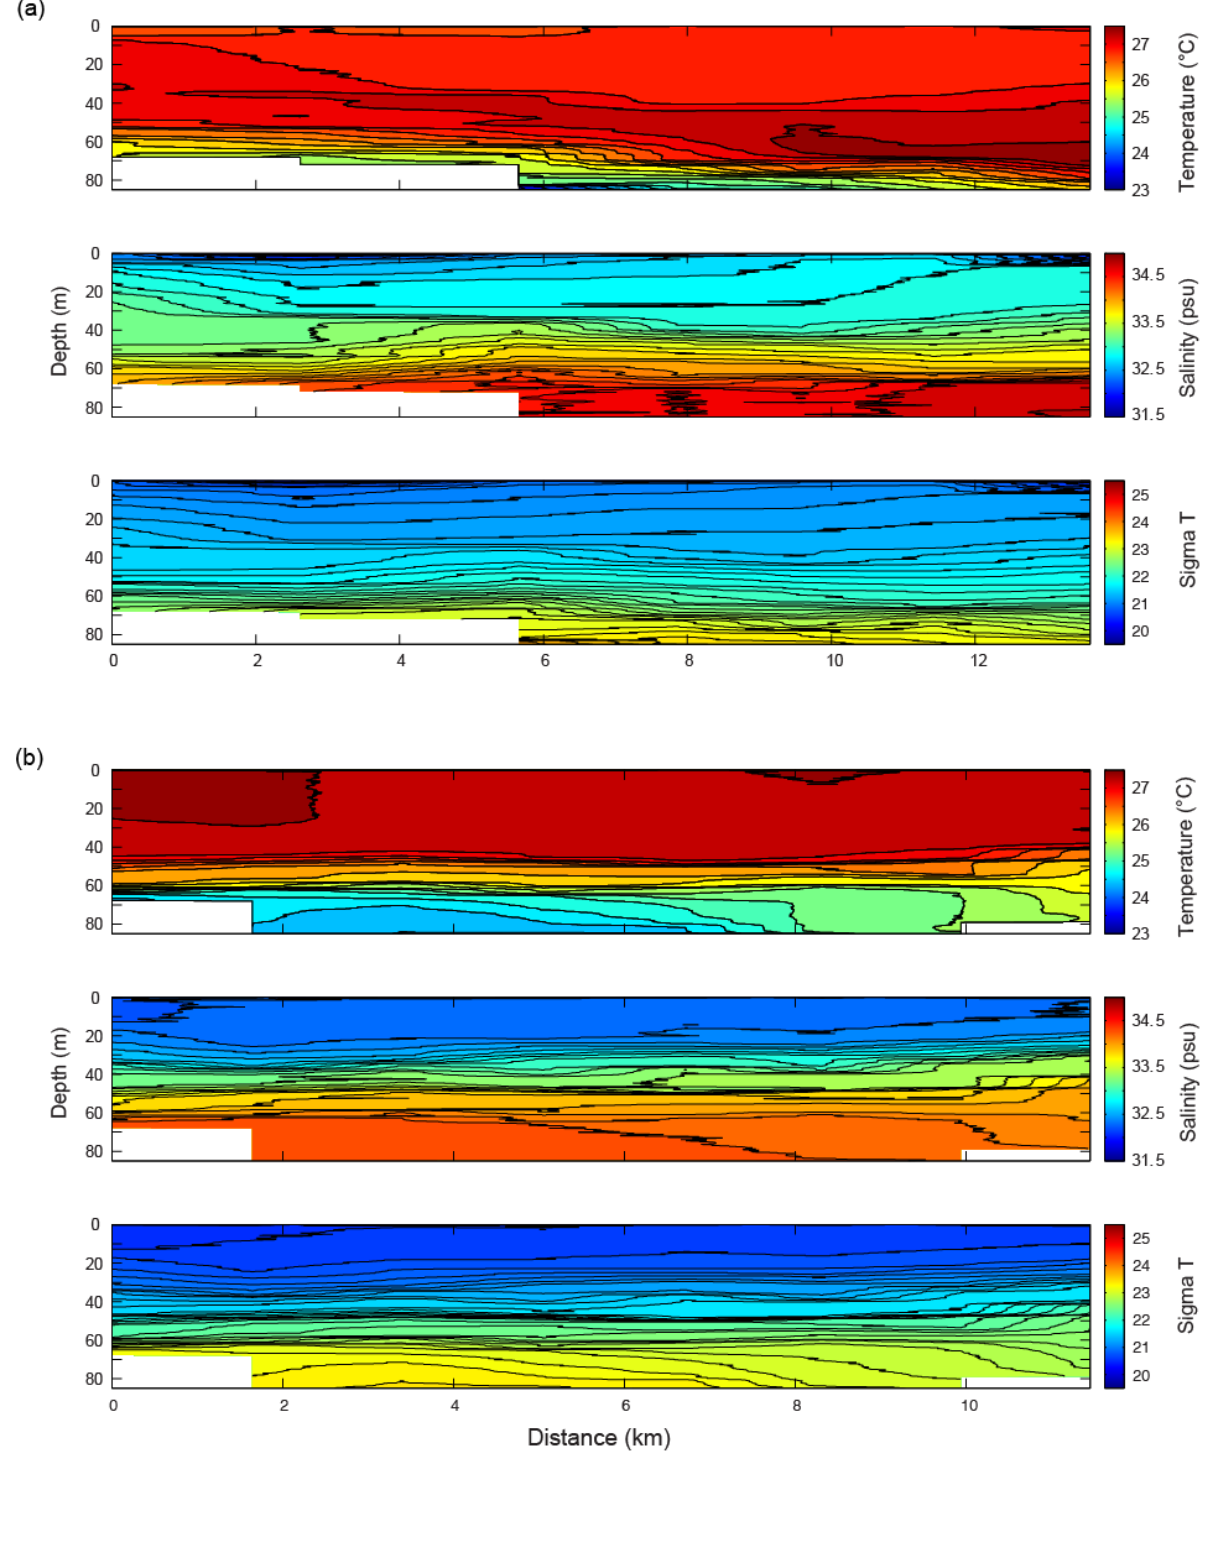
Figure 7. Contour plots for temperature, salinity and density (measured in sigma-t) for the two contrasting years; ( a ) 2011 and ( b )